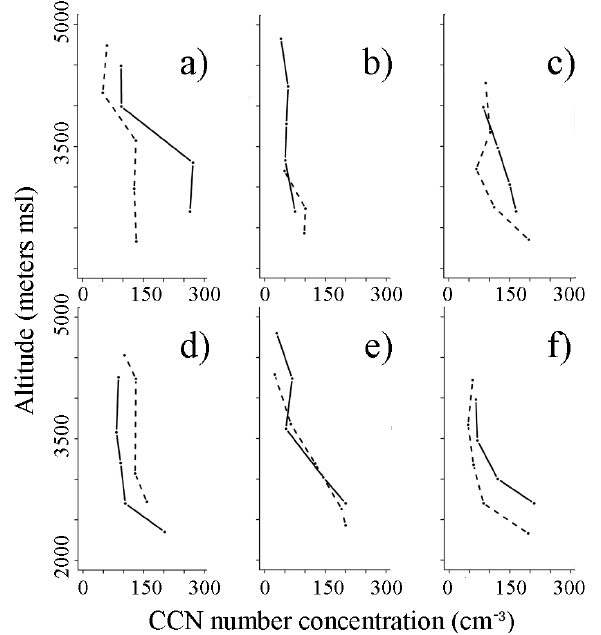
Fig. 9. Vertical profiles of N ccn collected during the (a) F1, (b) F4, (c) F5, (d) F6, (e) F7, (f) F8 flights. The plotted values are N ccn at SS = 0.46% for the northern stacks (solid line) and the southern stacksSupersaturation (SS) is maintained (dashed